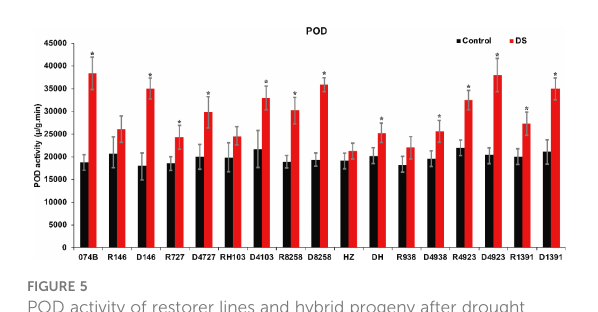
FIGURE 6 CAT activity of restorer lines and hybrid progeny after drought treatment. CAT represents catalase; DS represents drought stress treatment. Error bars denote standard deviations ( n = 3); “ * ” stands for signi fi cance between drought stress and control condition in the same cultivar (p ≤